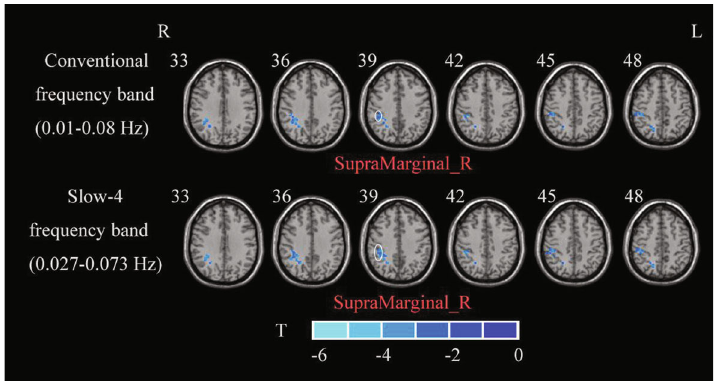
Figure 2: A two-sample t -test was performed between acute BGIS patients and HCs. R: right hemisphere; L: left hemisphere; BGIS: basal ganglia ischemic stroke; HCs: healthy controls; ALFF: amplitude of low frequency fl